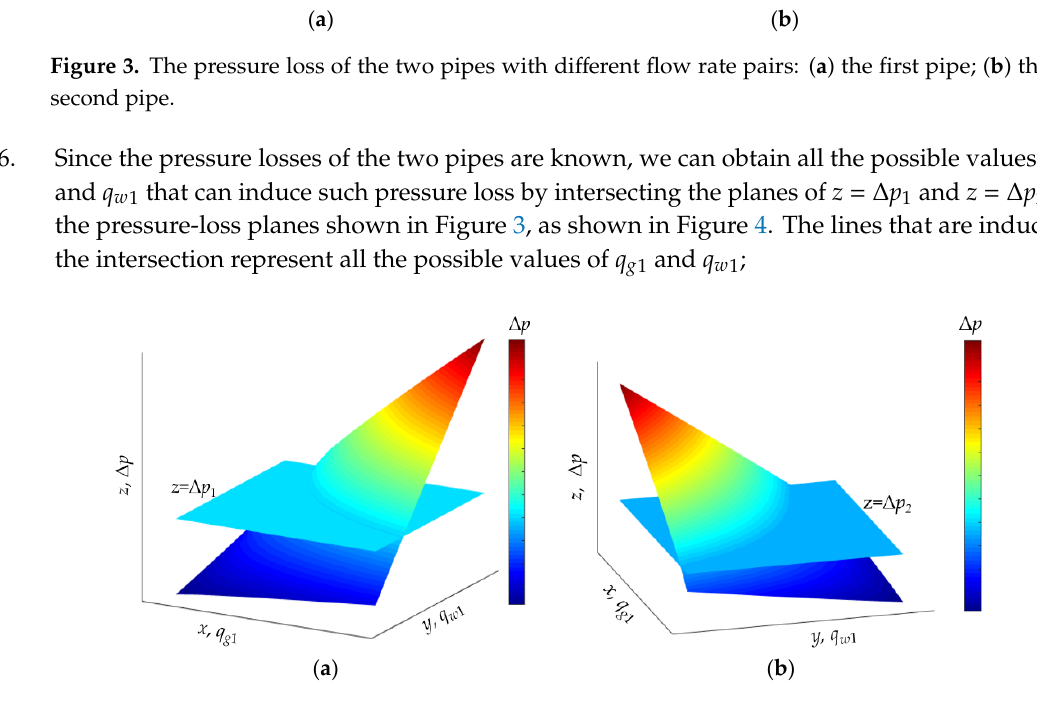
Figure 4. Intersection between the planes of z = Δ p 1 and z = Δ p 2 and the pressure ‐ loss planes: ( a ) the first pipe; ( b ) the second pipe.